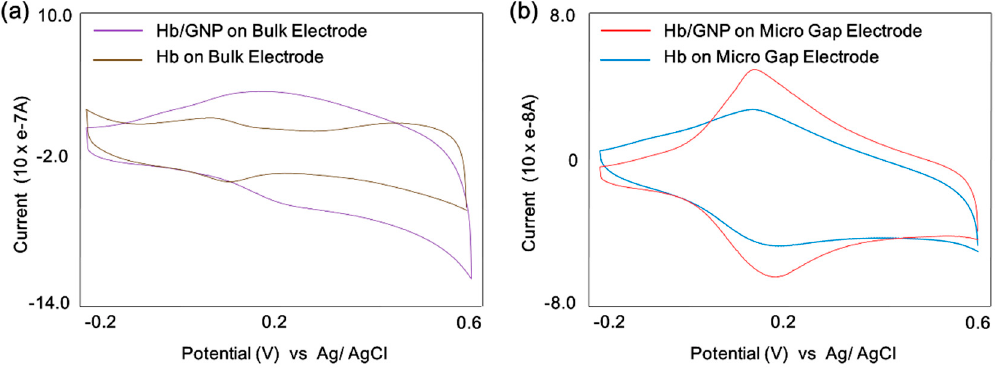
Figure 4. Cyclic voltammogram of ( a ) hemoglobin (Brown line) and hemoglobin/gold nanoparticle (Purple line) immobilized on bulk Au electrode, respectively; ( b ) hemoglobin (Red line) and hemoglobin/gold nanoparticle (Blue line) immobilized on micro-gap Au electrode, respectively.